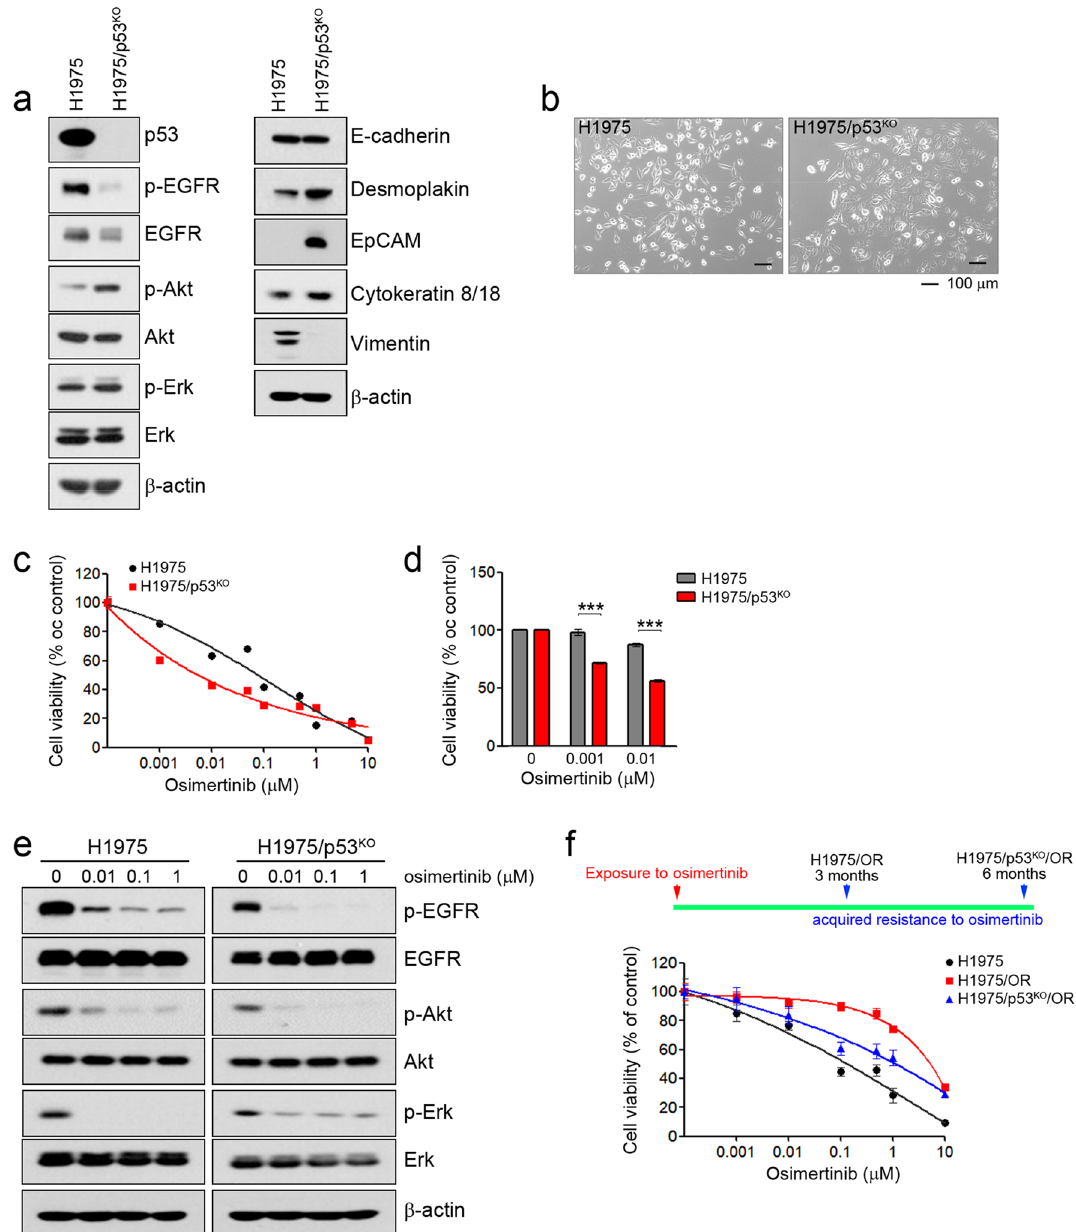
Figure 3. The effects of p53 on sensitivity to EGFR-TKIs in H1975 cells. Endogenous p53 was silenced using a Crisper/Cas9 knockout system in H1975 cells. ( a ) The indicated protein levels were analyzed by immunoblotting. ( b ) Cells were evaluated for morphologic changes that were consistent with MET using a light microscope. ( c , d ) Cells were treated with the indicated doses of osimertinib for 72 h, and cell viability was determined using MTT assays and cell counting. ( e ) Cells were treated with the indicated doses of osimetinib for 6 h, and EGFR-related signaling proteins were analyzed by immunoblotting. ( f ) Two gefitinib-resistant cells (H1975/OR and H1975/p53 KO /OR) were established as described in the Materials and Methods section. At 3 months after drug exposure, cells were treated with the indicated doses of osimertinib for 72 h, and cell viability was determined using MTT assays. *** p < 0.0005 compared with investigated whether such mutant p53 affects the sensitivity to EGFR-TKIs via EMT induction in cells with acti- vating EGFR mutations. When mutant p53-R273H was introduced into HCC827 and PC-9 cells, the induction of vimentin was observed in two cells (Fig. 4a). Although the changes of EMT-related molecules differed in the two cells, induction of the EMT-like phenotype was more evident in PC-9 cells than HCC827 via the reduction of E-cadherin, cytokeratin 8/18, EpCAM, and the induction of vimentin. EMT induction by mutant p53-R273H was also confirmed in other cells with wild-type or null p53 (Supplementary Fig. S2). Furthermore, the introduc- tion of mutant p53-R273H led to resistance to EGFR-TKIs in two cells (Fig. 4b). Lastly, we examined migratory